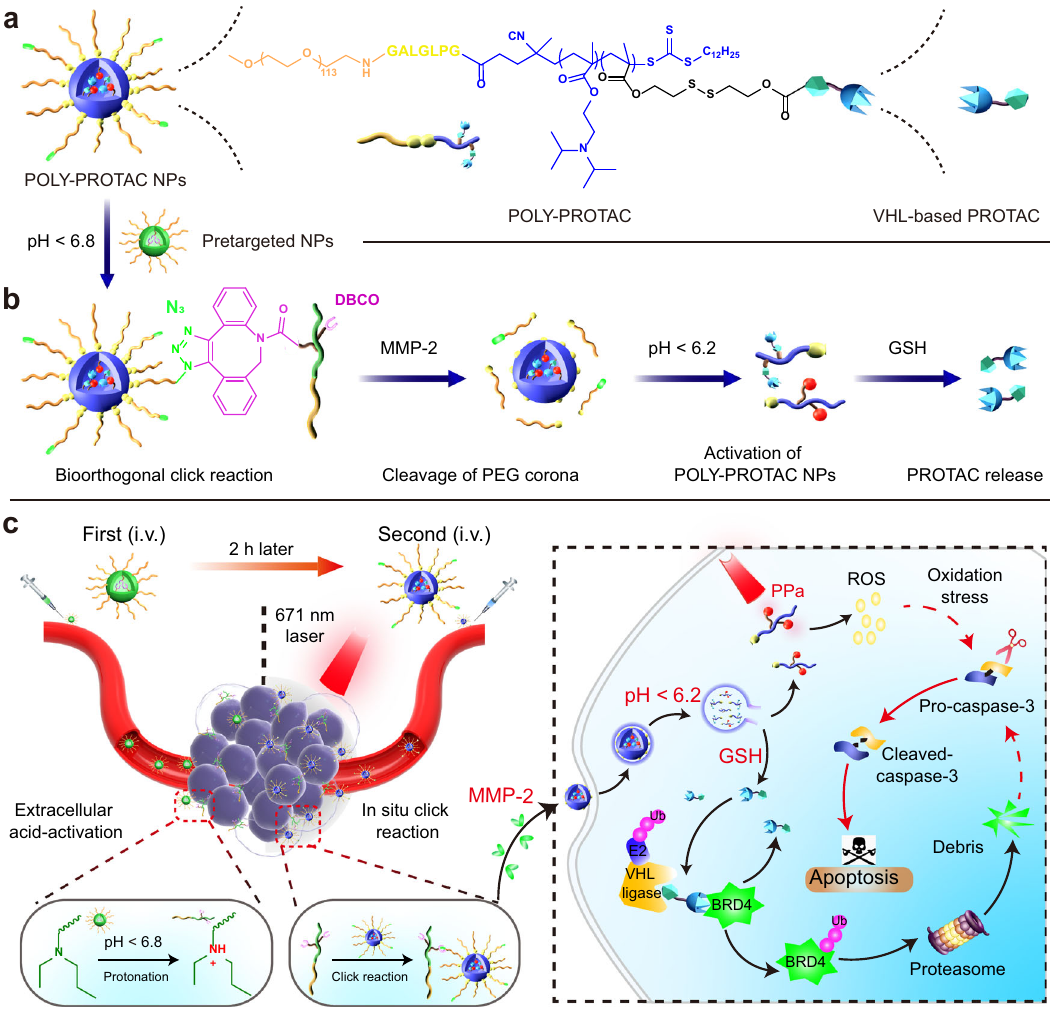
Fig. 1 | Schematic illustration of the bioorthogonal POLY-PROTAC NPs for tumour-speci fi c protein degradation and precise cancer therapy. a Cartoon illustration of the azide-functionalized bioorthogonal POLY-PROTAC NPs. POLY- PROTAC was engineered by integrating an MMP-2-liable PEG chain, an acid- activatable DPA moiety and a reduction-sensitive disul fi de spacer. b Schematic illustration of the extracellular acidity-triggered click reaction between POLY- PROTAC and DBCO-loaded pretargeted NPs and sequential activation of POLY-